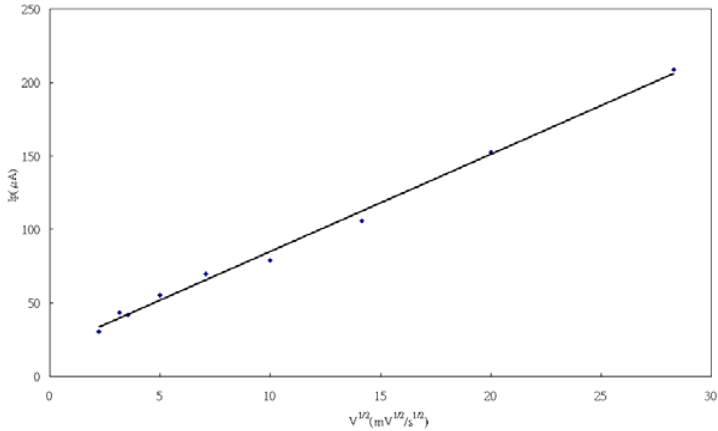
Figure 5. (A ) Magnitude of peak current (Ip) as a function of the square of the scan rate for coumarin reduction. Concentration: 3.73 × 10 − 3 M. (B ) Real potentials of coumarin reduction as a function of the logarithm of the scan rate. Concentration: 3.73 × 10 − 3